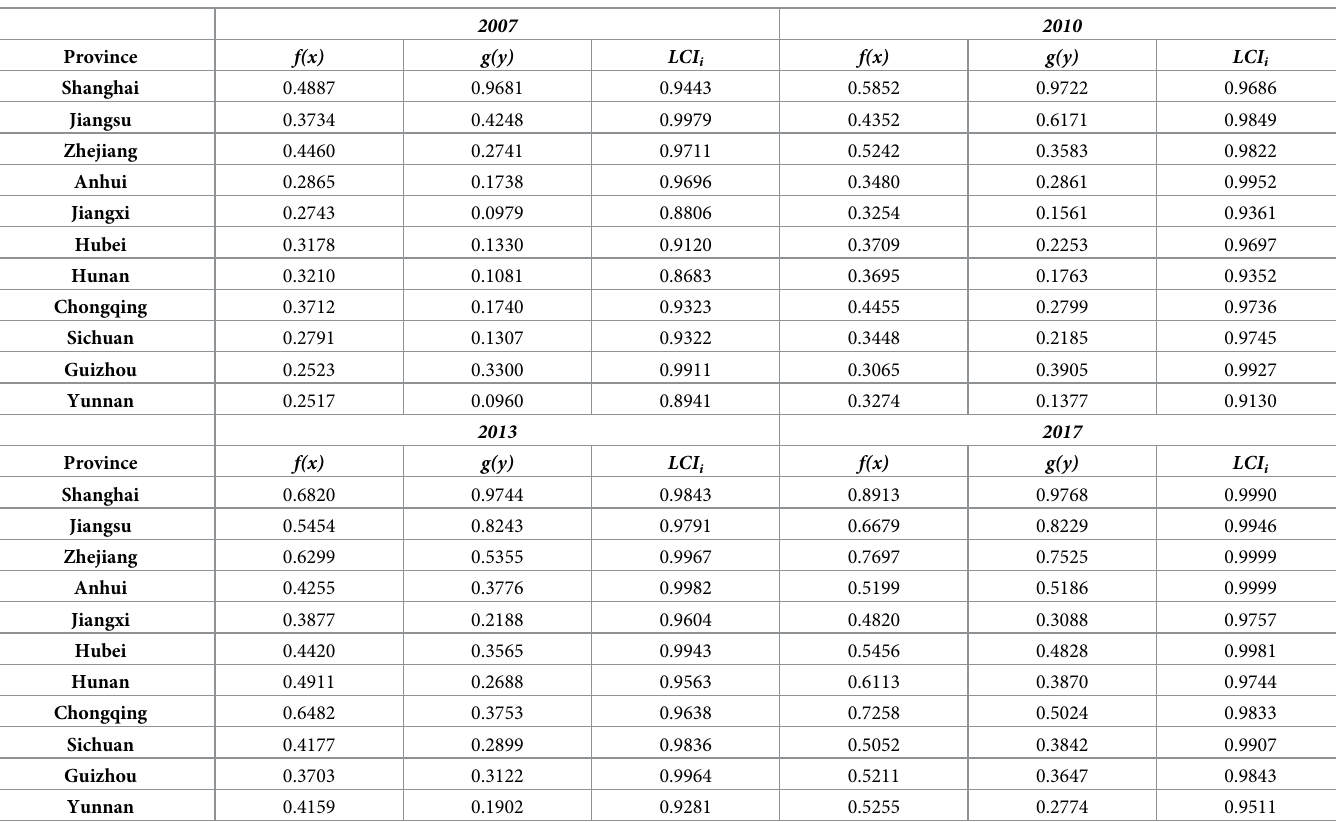
Table 5. Level consistency evaluation of the population-land urbanization in the YEB in 2007, 2010, 2013,